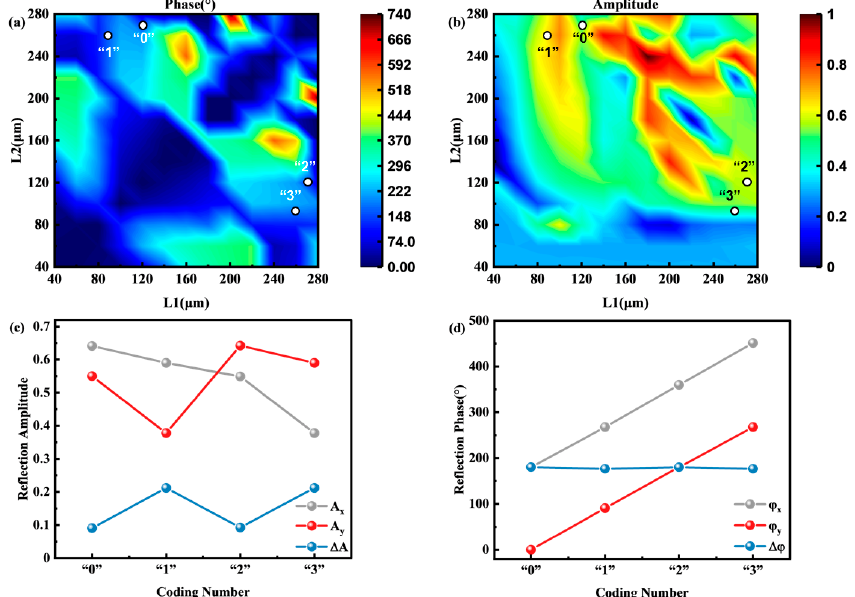
Figure 3. ( a , b ) The phase and amplitude spectra of silicon pillars changing L 1 and L 2 at 0.7 THz; the numbers in the figure indicate the size selection of the four coding structures. ( c ) The amplitude values A x along with the x-direction corresponding to the four coding structures; the amplitude value A y along the y-direction, and the amplitude difference ∆ A . ( d ) The phase value ϕ x along with the x-direction corresponding to the four coding structures; the phase value ϕ y along the y-direction and the phase difference value ∆ ϕ . Table 1. Parameter settings. (Unit: μ m).